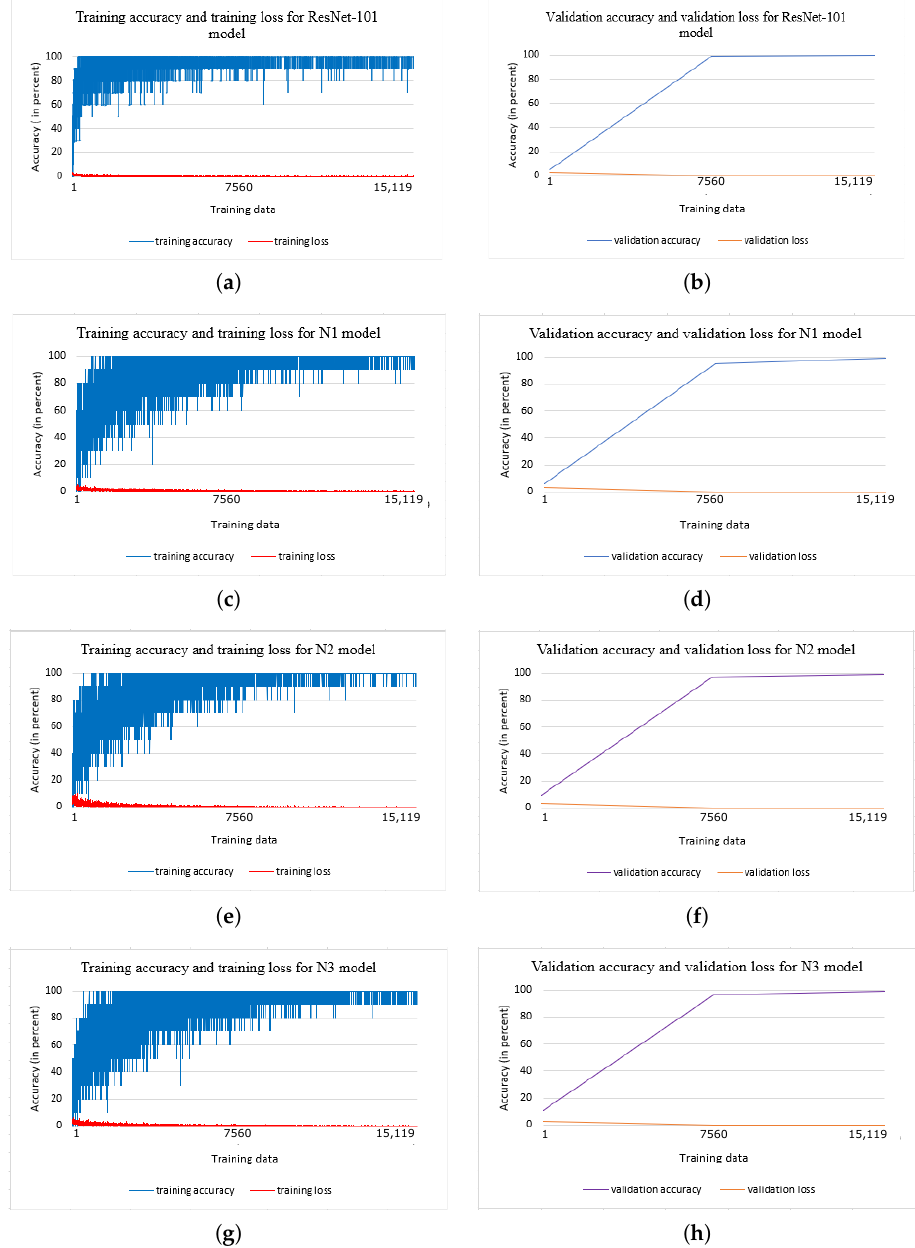
Figure 6. TA and TL and VA and VL were calculated for the ResNet-101 and N1, N2, and N3 models. “Smoothing the graph allows important patterns to stand out more clearly. The smoothened graphs of TA and TL, and VA and VL for the ResNet-101 and proposed N1, N2, and N3 models are shown in Figure 7. The TL curves for the models are shown in Figure 7a for ResNet-101, Figure 7c for N1, Figure 7e for N2, and Figure 7g for N3. The